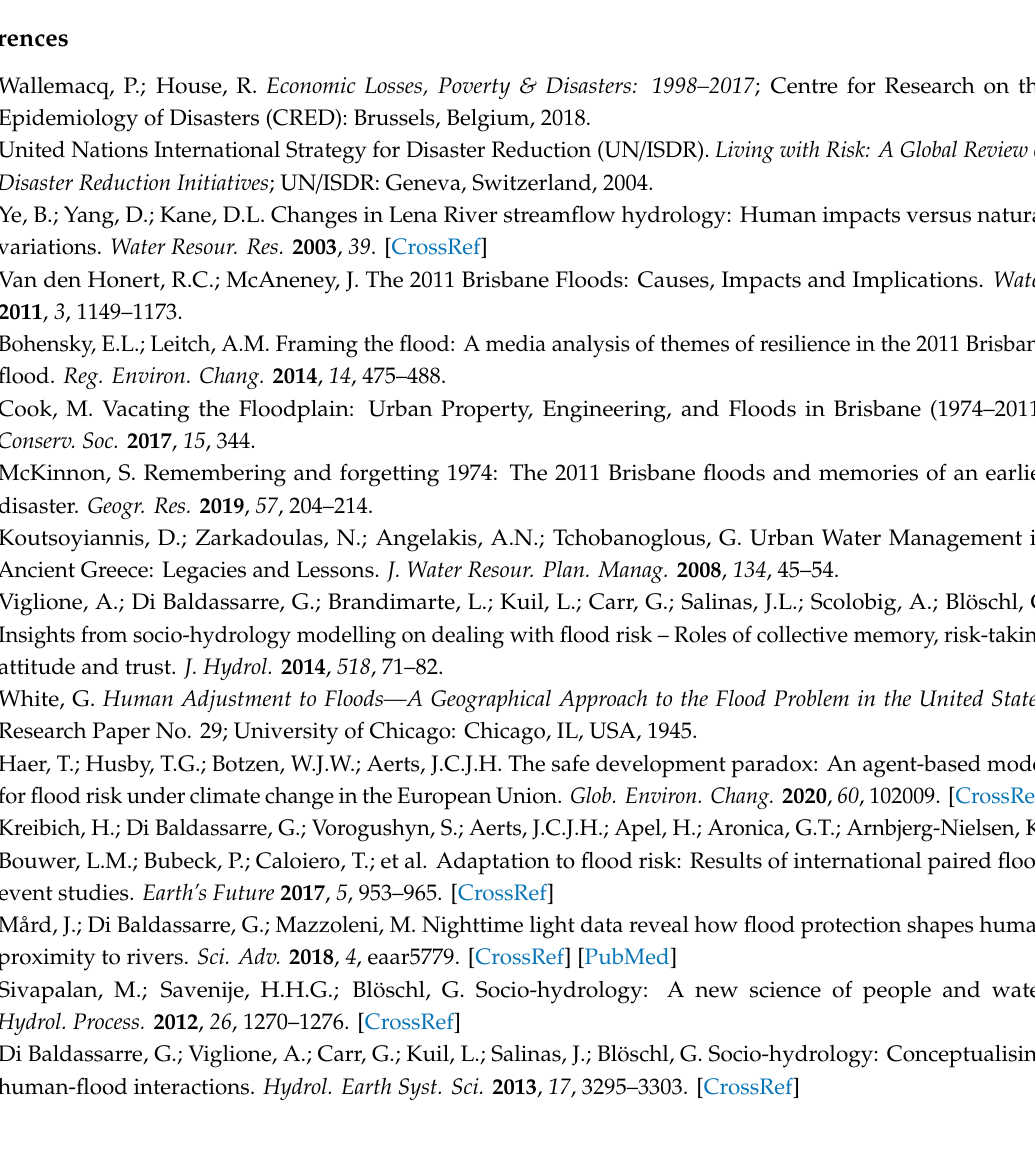
Figure S1: Variation of flood memory (top) and drought memory (bottom) for three di ff erent values of the level of bias β equal to 0 (orange), 1 (blue) and 10 (magenta), Figure S2: Flood peaks for values of the level of bias β equal to 1 (top, blue) and 10 (bottom, magenta), Figure S3: Variation of the storage coe ffi cient (left side) and reservoir storage (right side) for three di ff erent values of memory decay rate µ , equal to 0.10 year − 1 (light green), 0.15 year − 1 (brown) and 0.20 year − 1 (orange), Figure S4: Evaluation of the socio-hydrological model comparing the simulated flow data (red) with the observed ones (black) at Wivenhoe Tailwater from May 1986 to June 2010, Figure